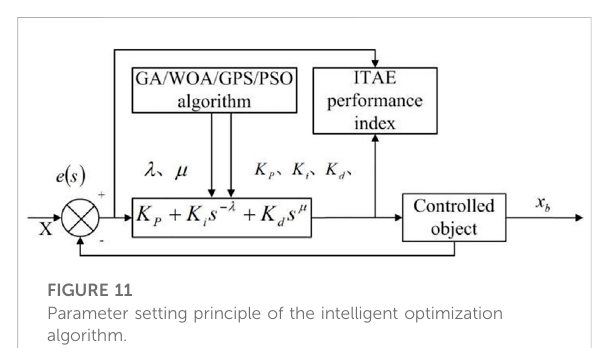
FIGURE 11 Parameter setting principle of the intelligent optimization